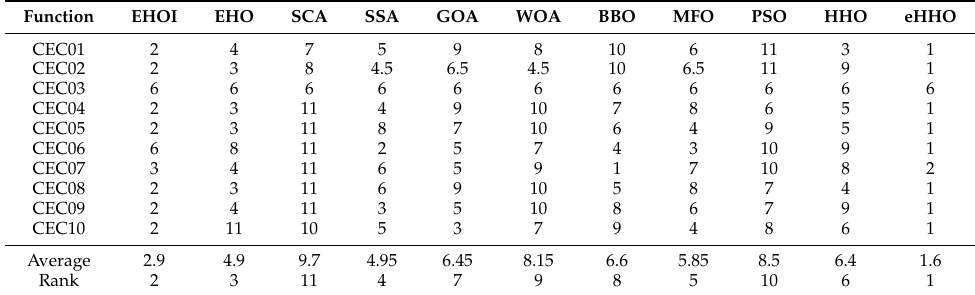
Table 4. Friedman test ranks for the compared algorithms over 10 CEC2019 functions.